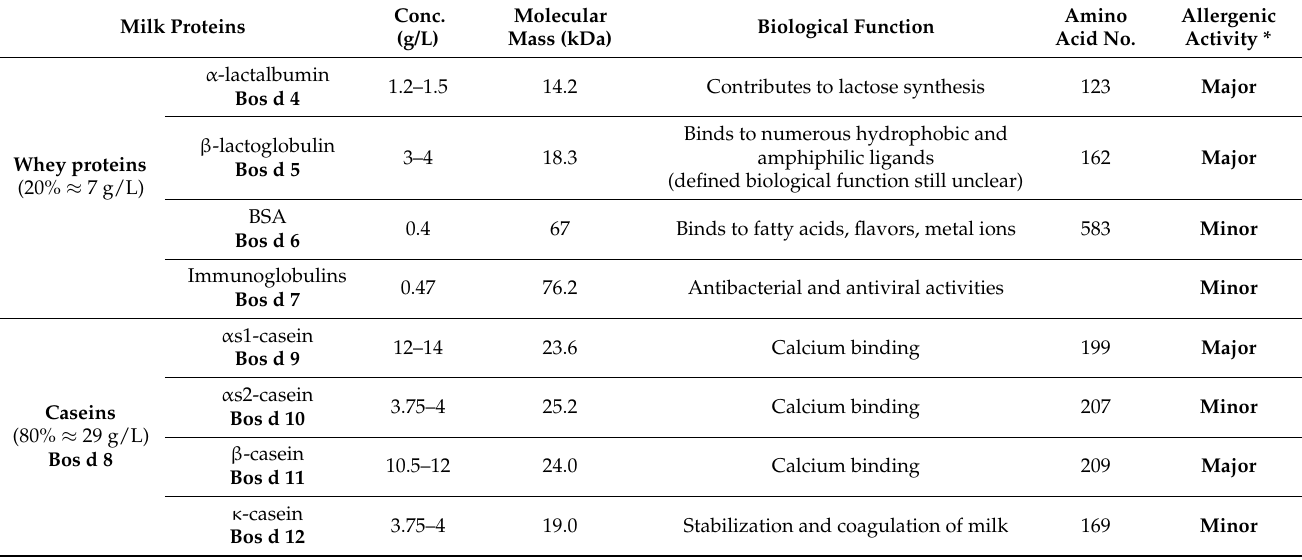
Biological Function